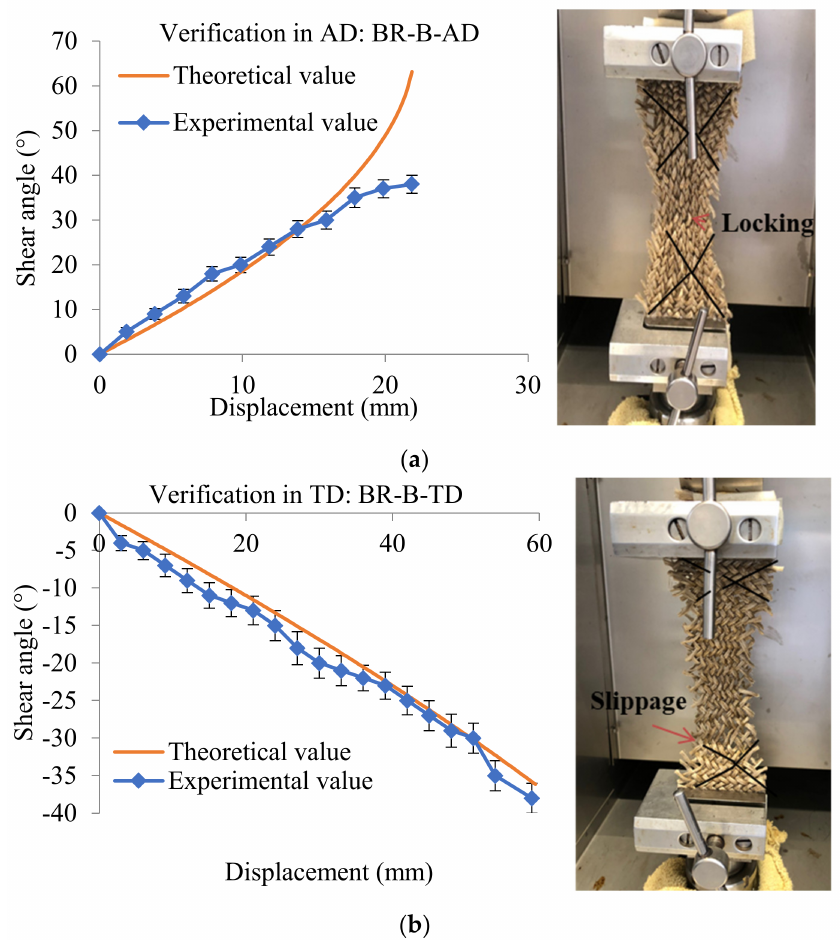
Figure A1. Thermo-conditional verification of analytical model: ( a ) BR-B-AD and ( b )